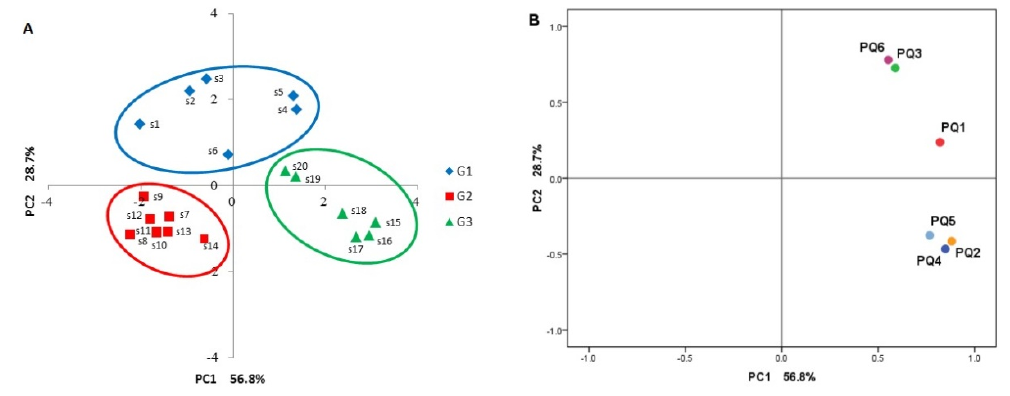
Figure 4. Score plot of 20 KMI samples by PC1 and PC2 from PCA. ( A ) Scatter diagram of KMI samples from three different groups (G1, G2, and G3); ( B ) Loading plot of six components for PC1 and PC2.